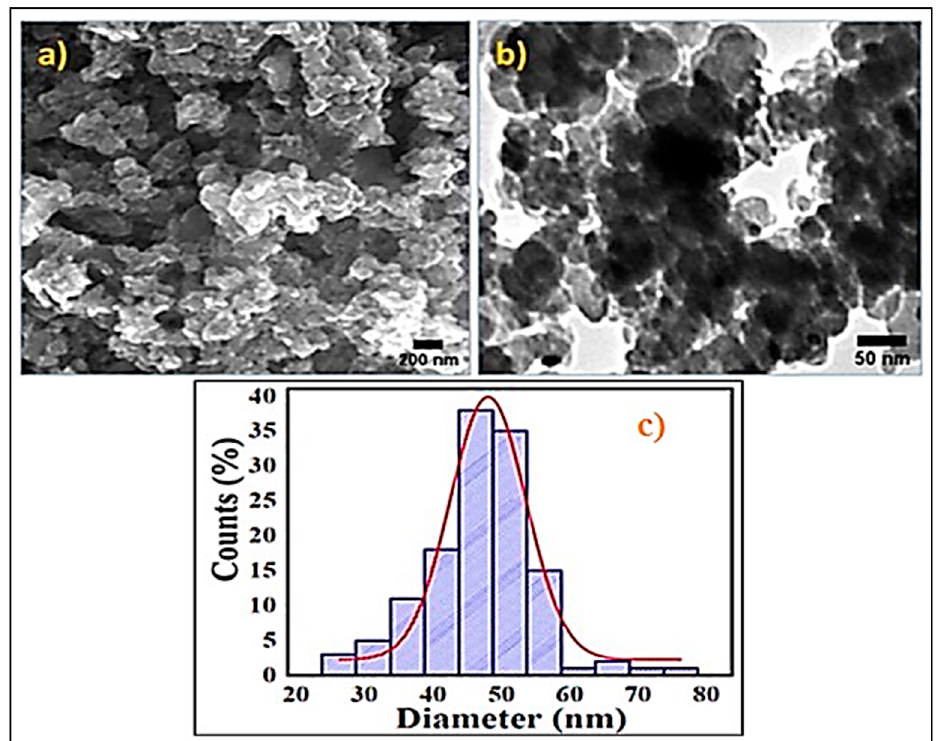
Figure 3. ( a ) SEM image of Chitosan-ZnO NPs; ( b ) TEM Image of Chitosan-ZnO NPs; ( c ) Size distribution curve.